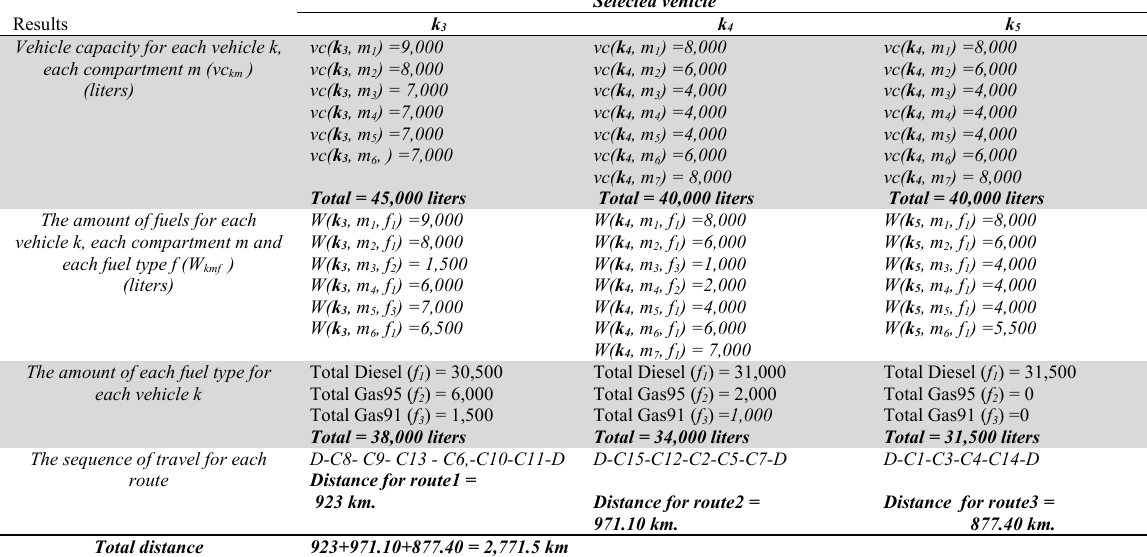
Selected vehicle